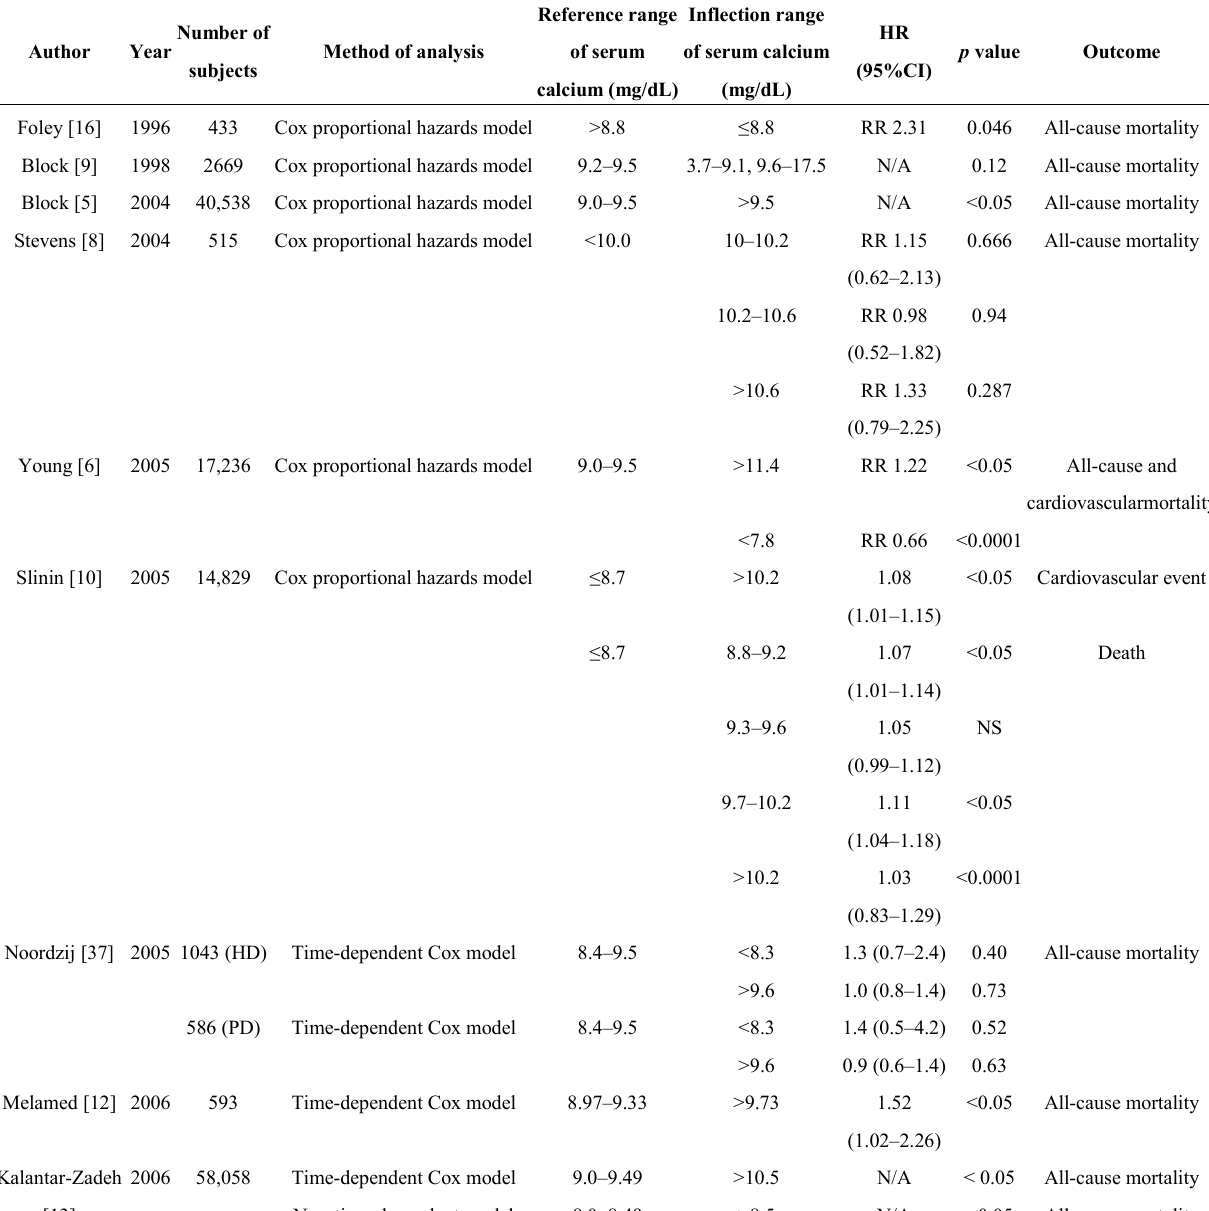
Table 2. Association between serum calcium levels and mortality risk in dialysis